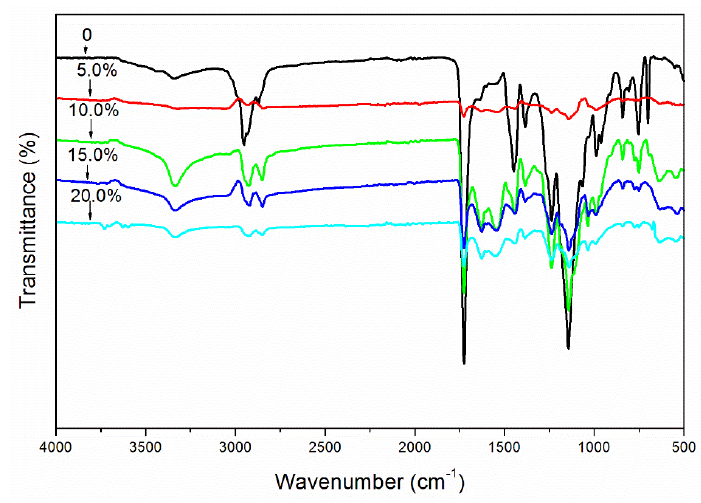
Figure 7. SEM of paint films corresponding to microcapsule (0.75:1 core-wall ratio) concentrations of: